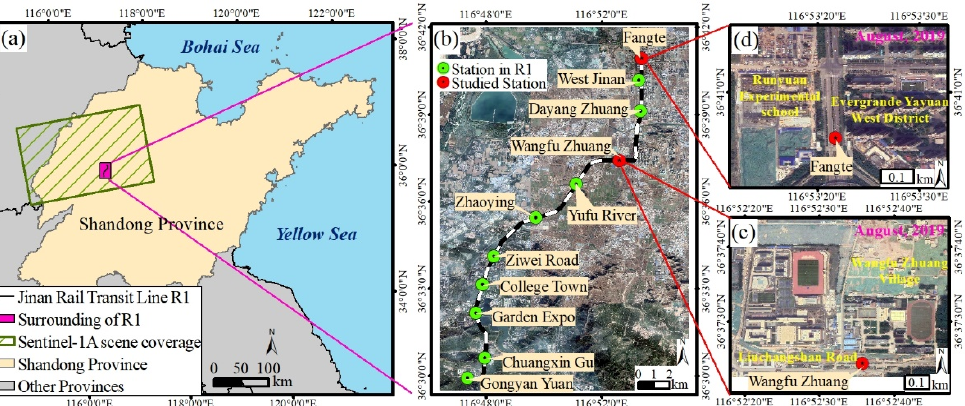
Figure 1. Study area: ( a ) location of Jinan Rail Transit Line R1, ( b ) location of the Fangte and Wangfu Zhuang Stations and ( c , d ) their surroundings.